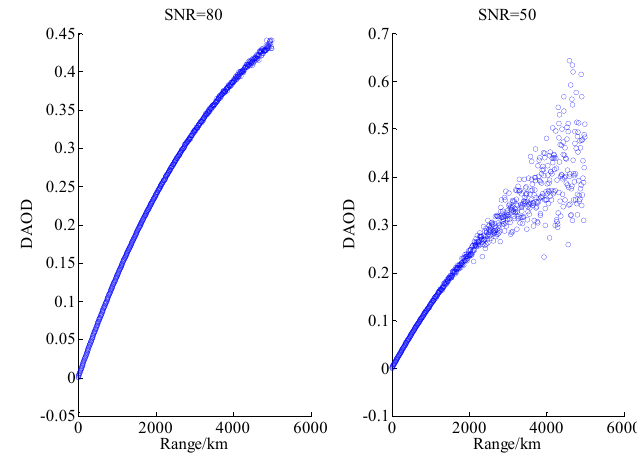
Figure 8. Differential absorption optical depth (DAOD) of DW-DIAL with SNR of 80 and 50.